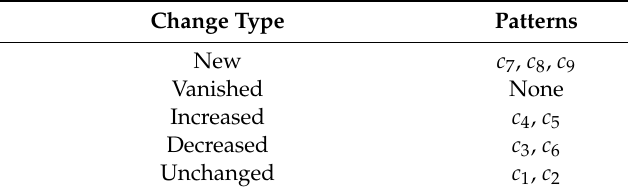
Table 4. Change detection results for User